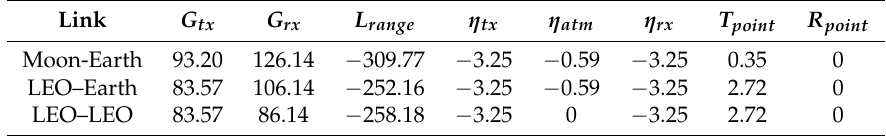
Table A3. Link terms values used for the three optical link scenarios for MOCT. All values are in